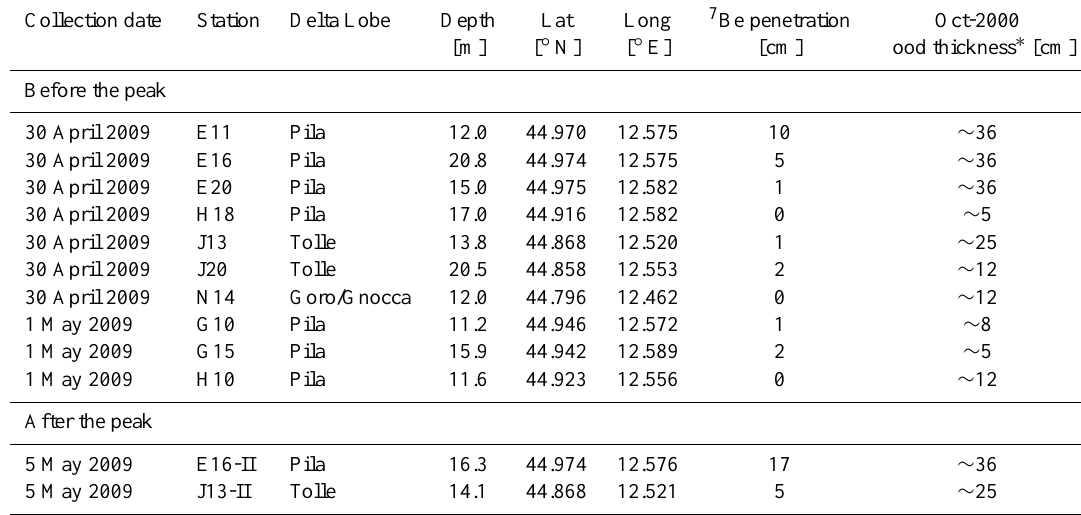
Table 5. Penetrations of 7 Be in sediment cores collected in the Po prodelta before and after the peak discharge. Thicknesses of the October 2000 flood estimated via radiographs were shown as